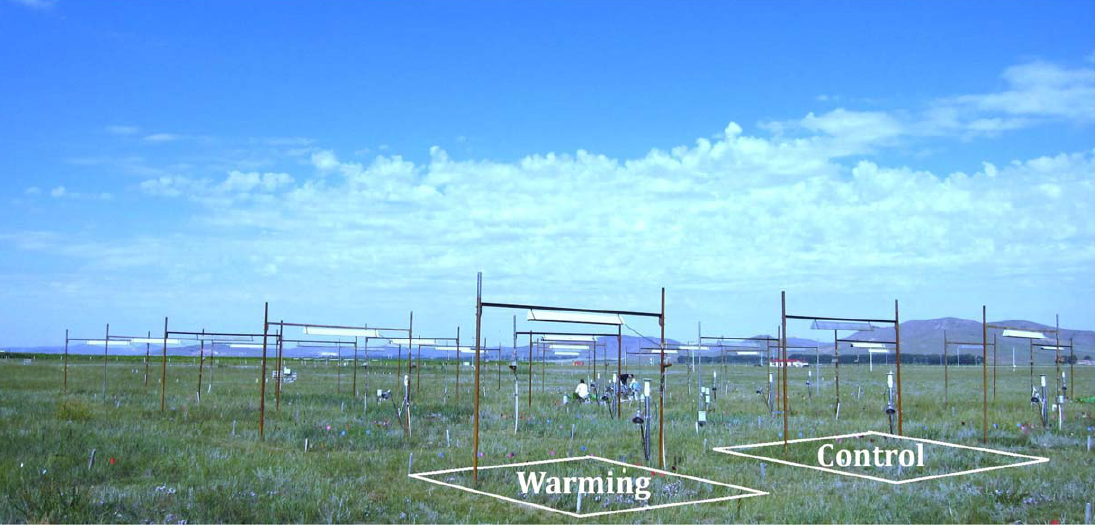
Figure 1. Layout of the experiment plots in a temperate steppe in northern China. Infrared heaters were suspended as the heating sources at the warming plots while ‘dummy’ heaters were suspended to simulate shading effects of the infrared heater at the control plots.